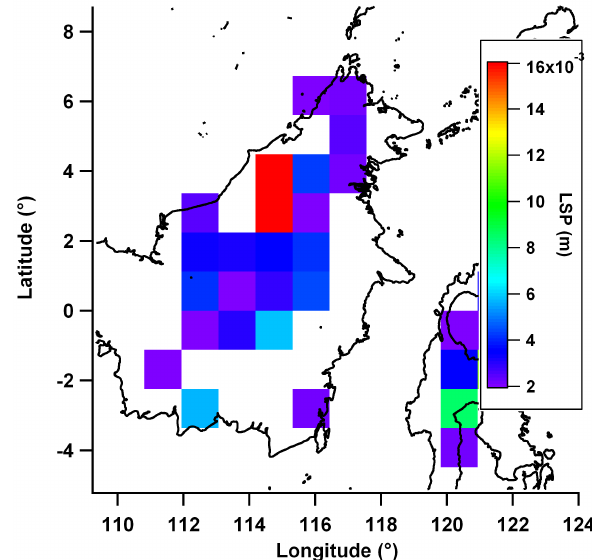
Fig. 7. Average daily large scale precipitation (m) from the European Centre for Medium-Range Weather Forecast Integrated Forecasting System model reanalysis (BADC, 2006b) at 1 . 125 ◦ × 1 . 125 ◦ resolution during OP3-III. Values below 2 × 10 − 3 m are not shown for